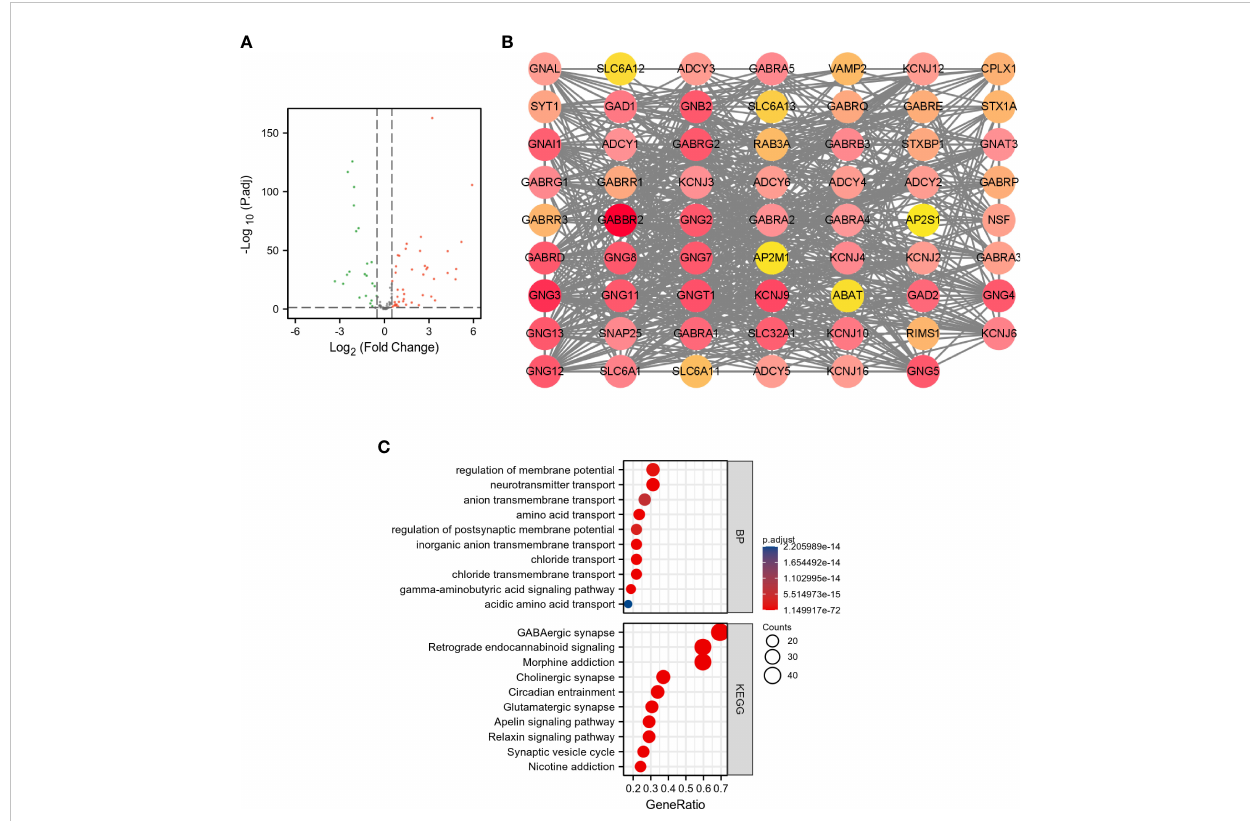
FIGURE 1 Analysis of DEGRGs in breast cancer. (A) Volcano plot of GRGs between tumor and normal groups. The green dots represent down-regulated genes, and the red dots represent up-regulated genes. (B) PPI network of DEGRGs. (C) Enrichment analyses of